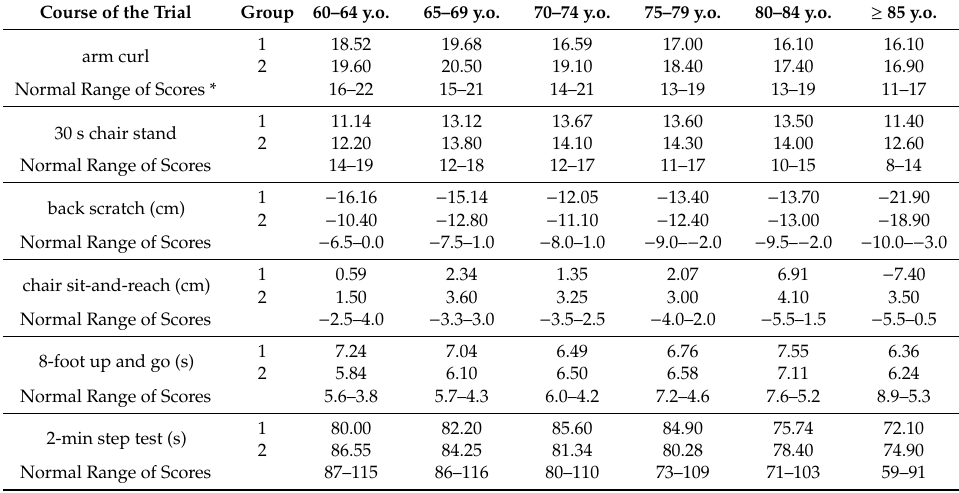
Table 6. Comparison of the functional fitness levels of older adult men in di ff erent age categories with the American standards.